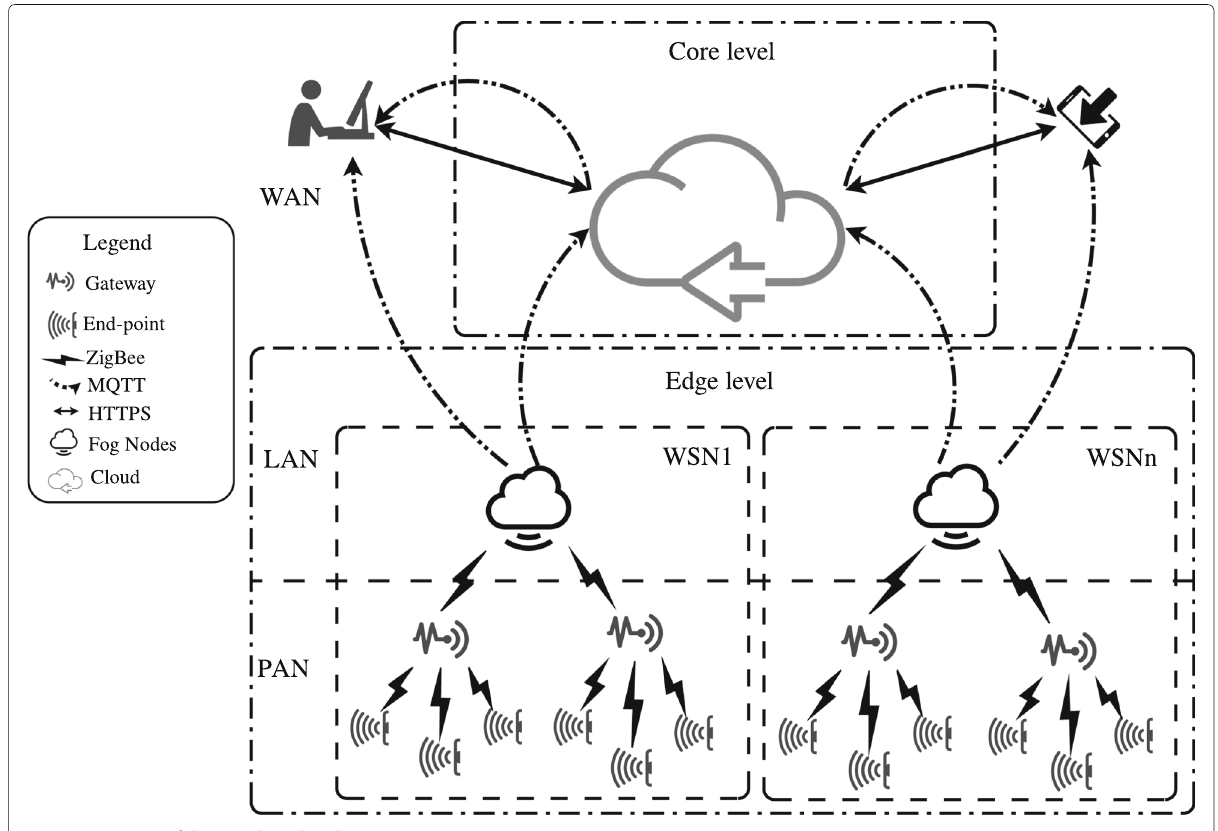
Fig. 2 Ecosystem of the Developed